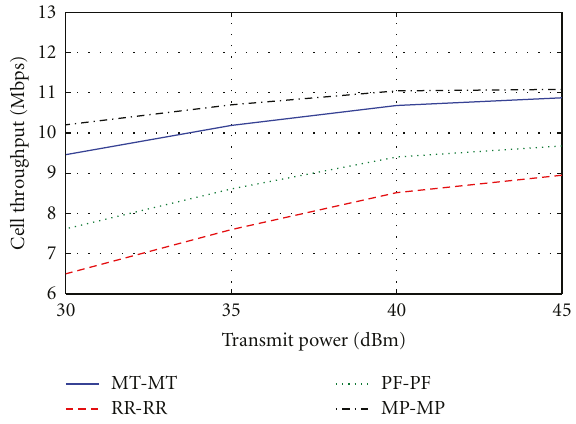
Figure 6: Average cell throughput in the whole cell with various transmit power.